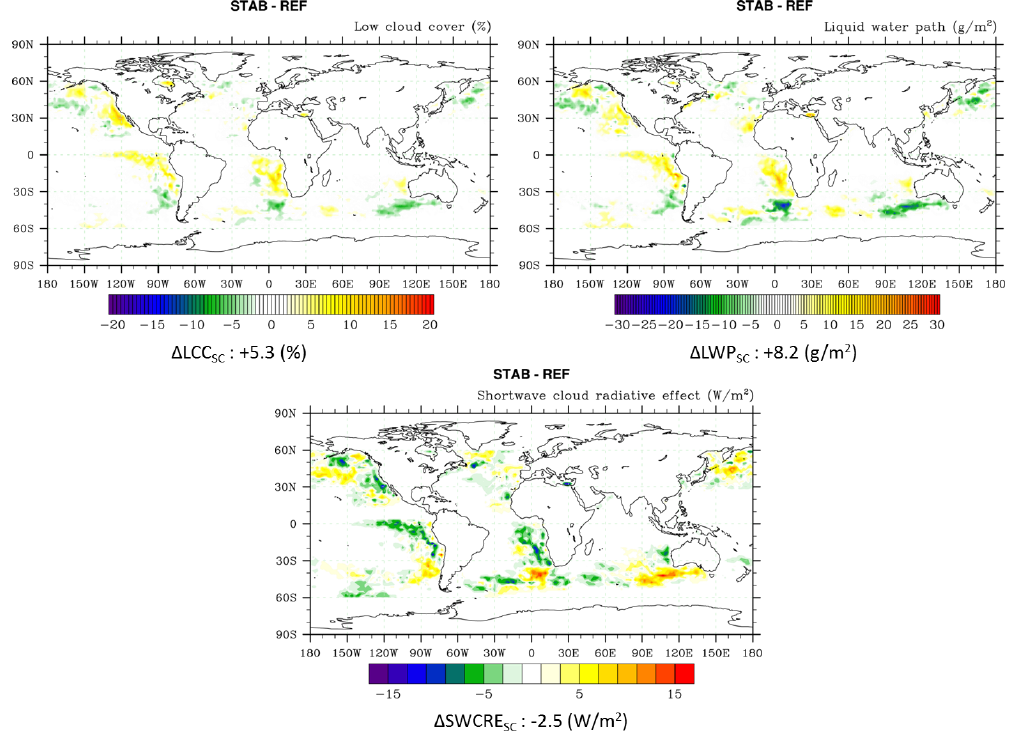
Figure 10. Difference in low-cloud cover, LWP and SWCRE in stratocumulus regions between a simulation with a sharp stability function and the reference simulation. Values below each panel are in-regime values.